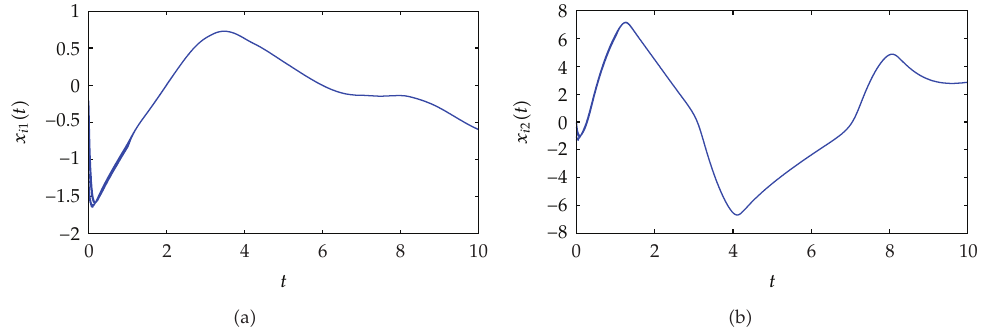
Figure 3: The trajectories of the state variables of x i 1 and x i 2 (cid:3) i (cid:8) 1 , 2 ,..., 5 (cid:4) in system (cid:3) 4.3 (cid:4) under pinning